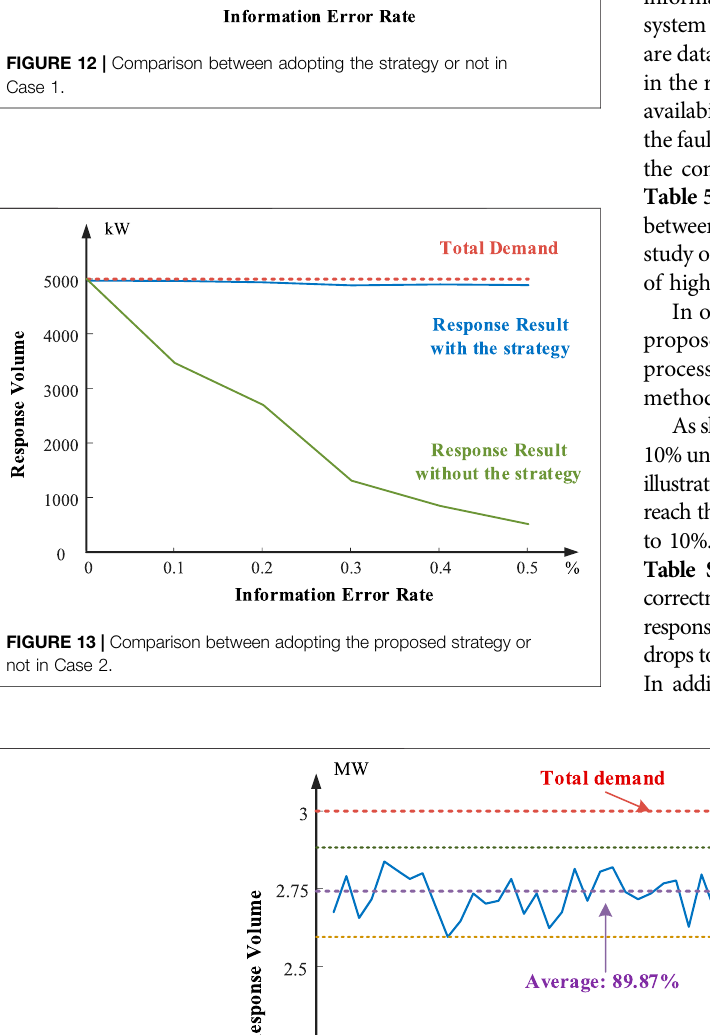
Frontiers in Energy Research |